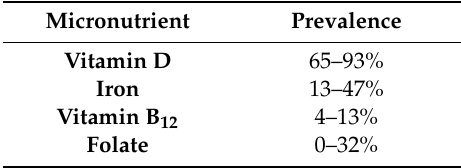
Table 1. Micronutrient deficiencies prior to bariatric surgery (BS)